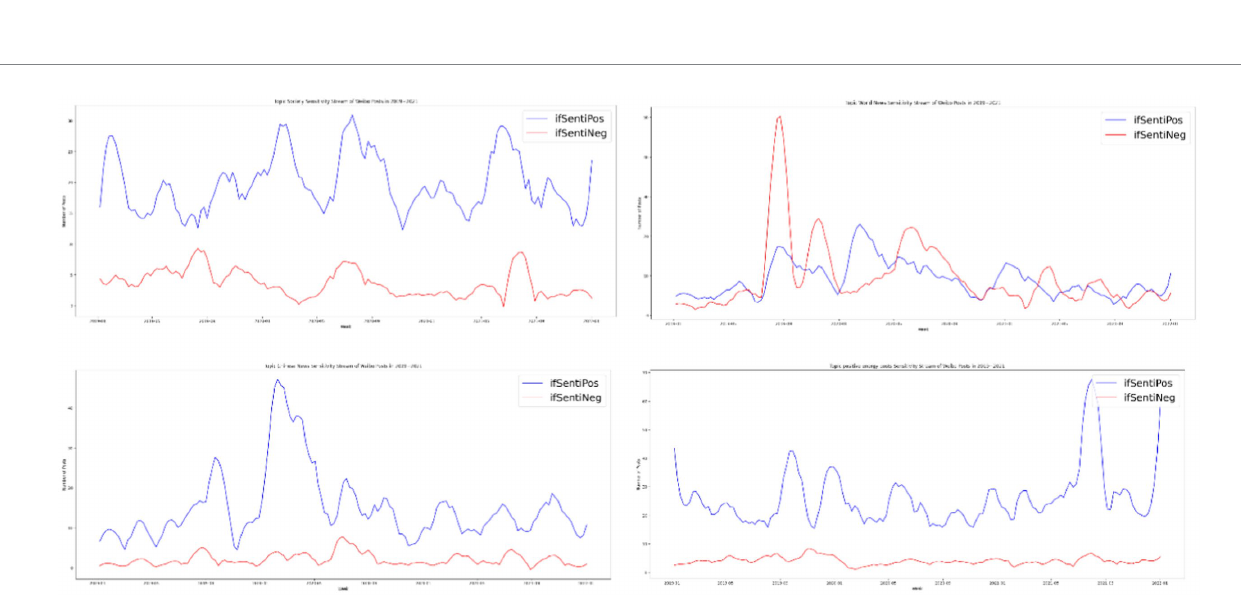
FIGURE 10 Positive and negative sentiment in the news by topic; upper left, society; upper right, world news; lower left, Chinese political news; lower right, positive energy posts.